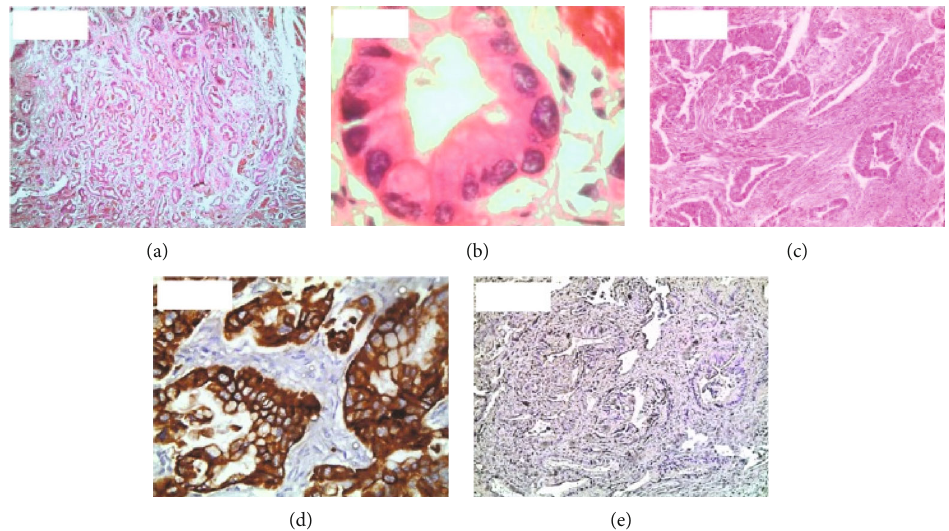
Figure 1: (a) Pancreatobiliary-type carcinoma with a tubular pattern (hematoxylin-eosin, 40x). (b) Pancreatobiliary-type carcinoma with marked nuclear atypia (hematoxylin-eosin, 400x). (c) Pancreatobiliary-type carcinoma with desmoplasia (hematoxylin-eosin, 100x). (d) Pancreatobiliary-type carcinoma with CK7 positivity (immunohistochemistry, 400x). (e) Pancreatobiliary-type carcinoma with CK20 negativity (immunohistochemistry, 100x).